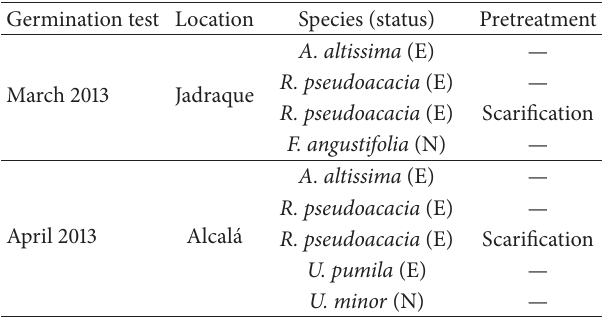
Table 1: Summary of multispecies comparison germination tests indicating the native and exotic species tested within each location and the presence/absence of applied